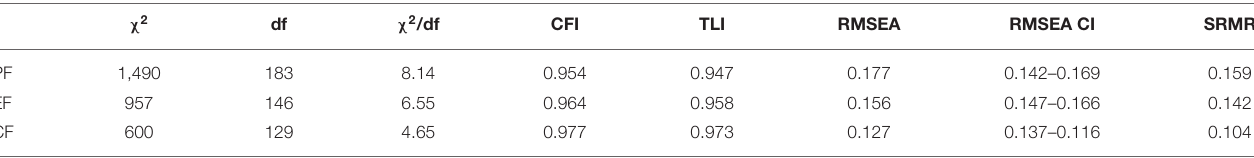
TABLE 4 | Fit of the structural